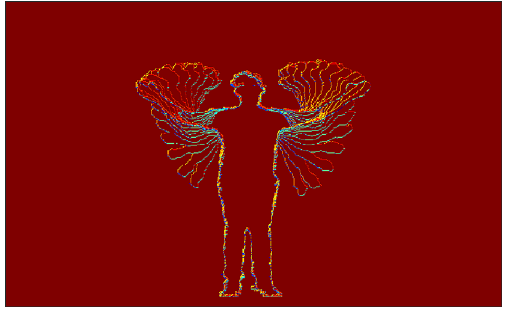
Fig. 4 Enhanced motion history image of two hand wave